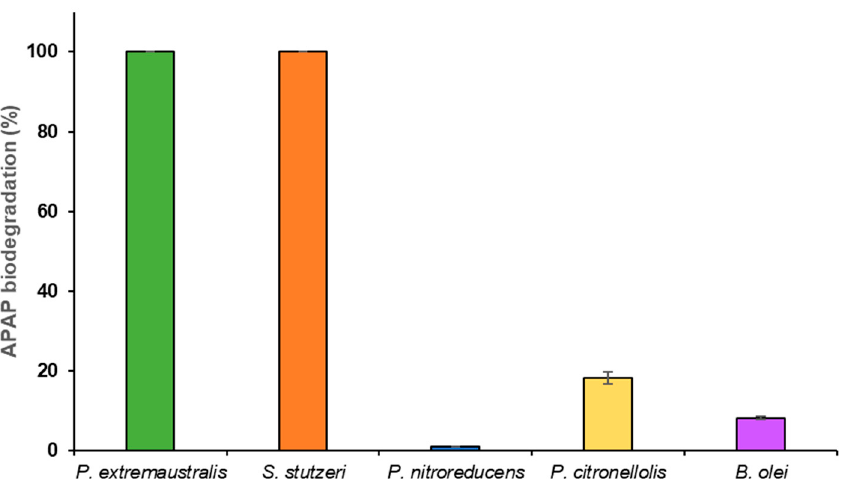
Figure 2. APAP biodegradation in solution by different bacterial strains in the presence of 10 mg L − 1 of the drug after 24 h of incubation.